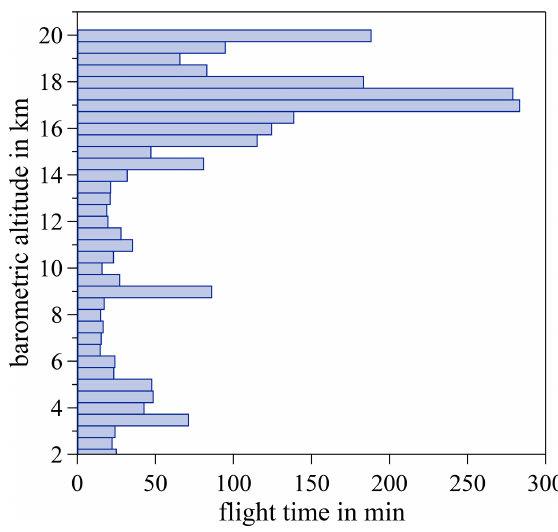
Figure 6. Total sampling time of the ERICA in different bins of altitude during all StratoClim research flights in Kalamata, Greece, in 2016 and Kathmandu, Nepal, in